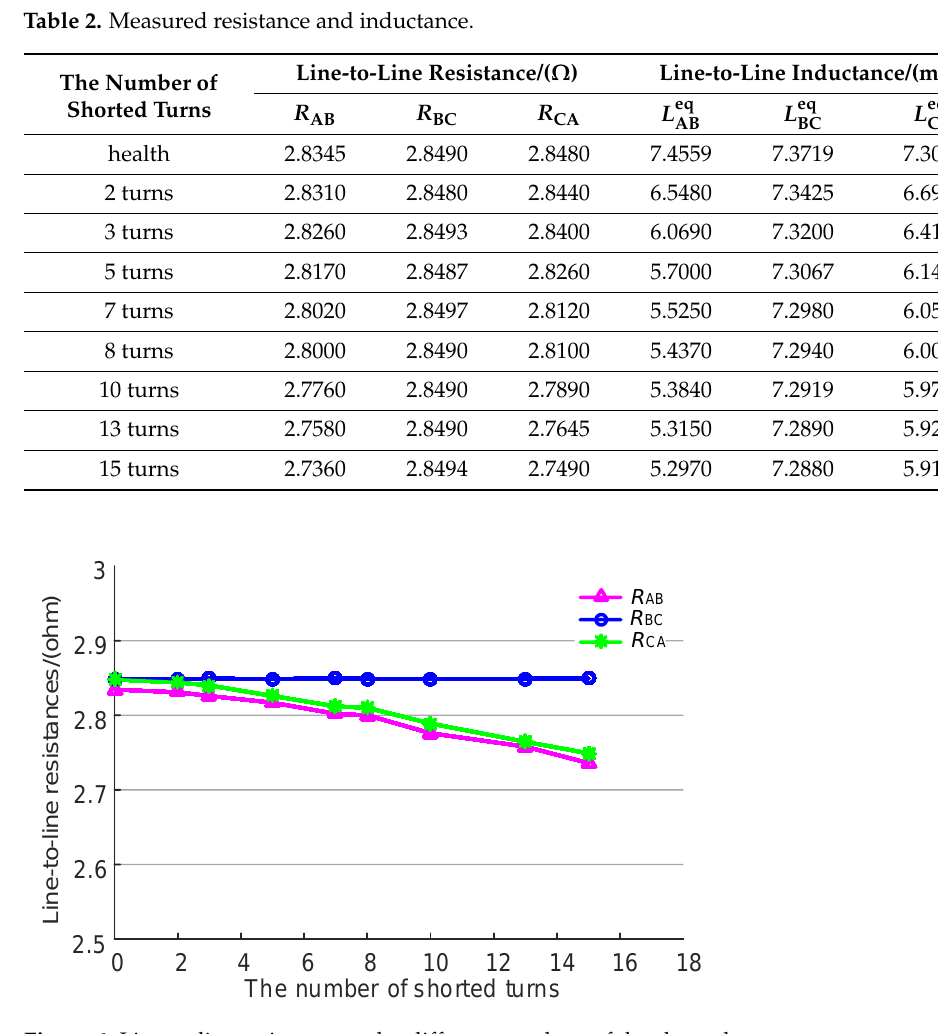
Figure 6. Line-to-line resistance under different numbers of the shorted turns.